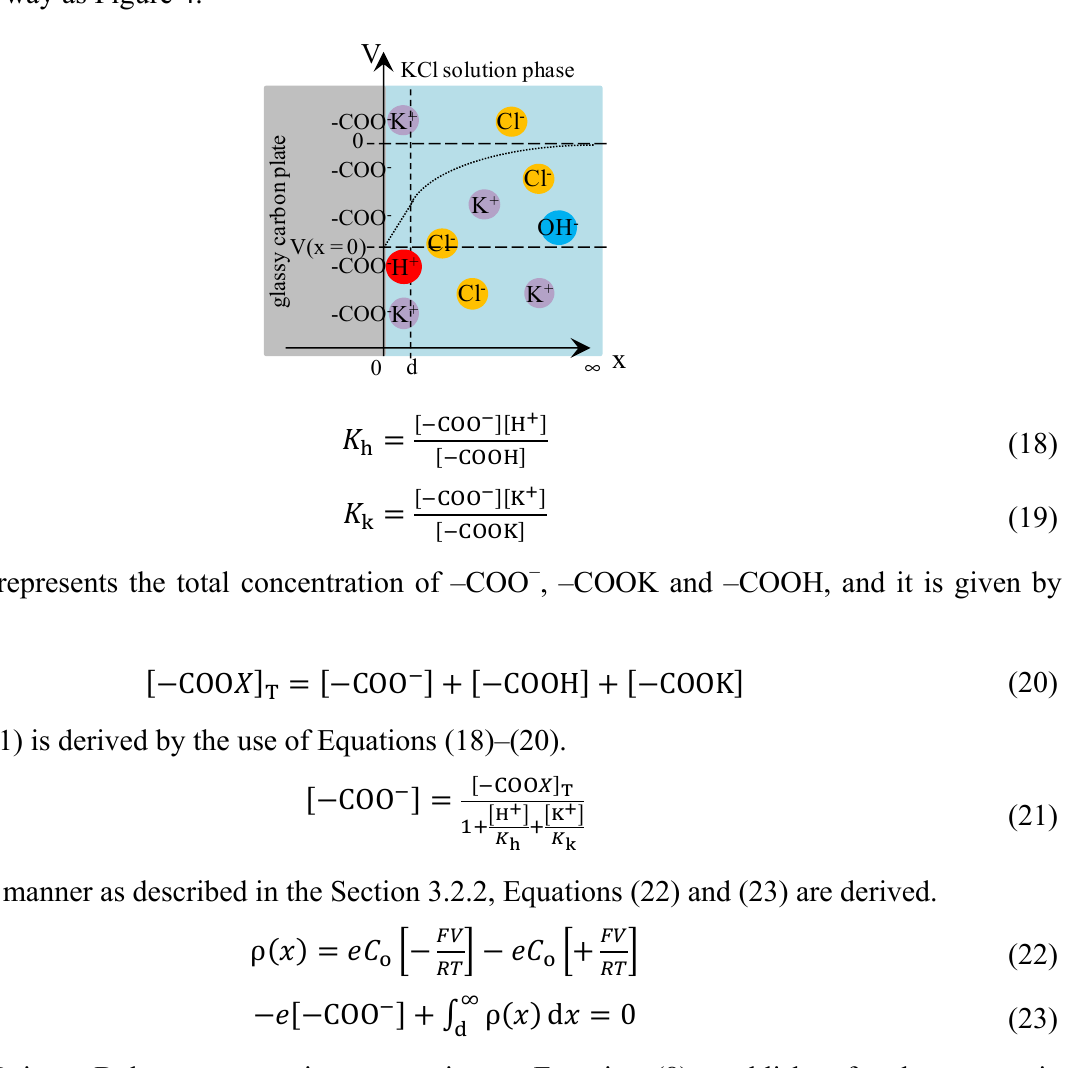
Figure 8. Interface between the surface-modified glassy carbon plate and KCl solution. Some potassium ions are in the state of adsorption to –COO − . Coordinate system is set in the same way as Figure